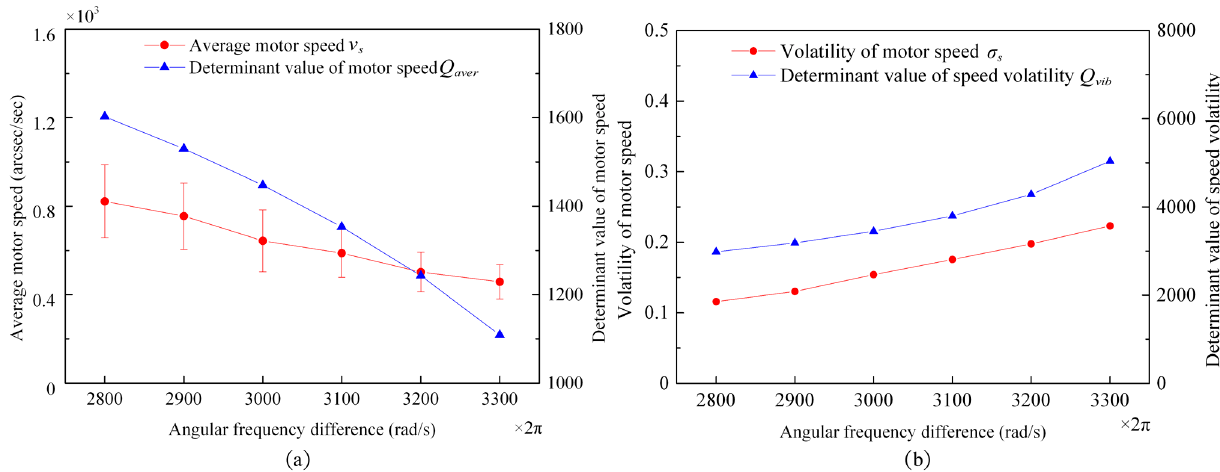
Figure 30. An experimental diagram of the variation trend of characteristic variables with frequency difference: ( a ) an experimental diagram of the motor’s average speed, v s , and the motor’s average speed determining factor, Q aver , with frequency difference; and ( b ) an experimental diagram of the speed volatility, σ s , and the speed volatility determinant, Q vib , with frequency difference.